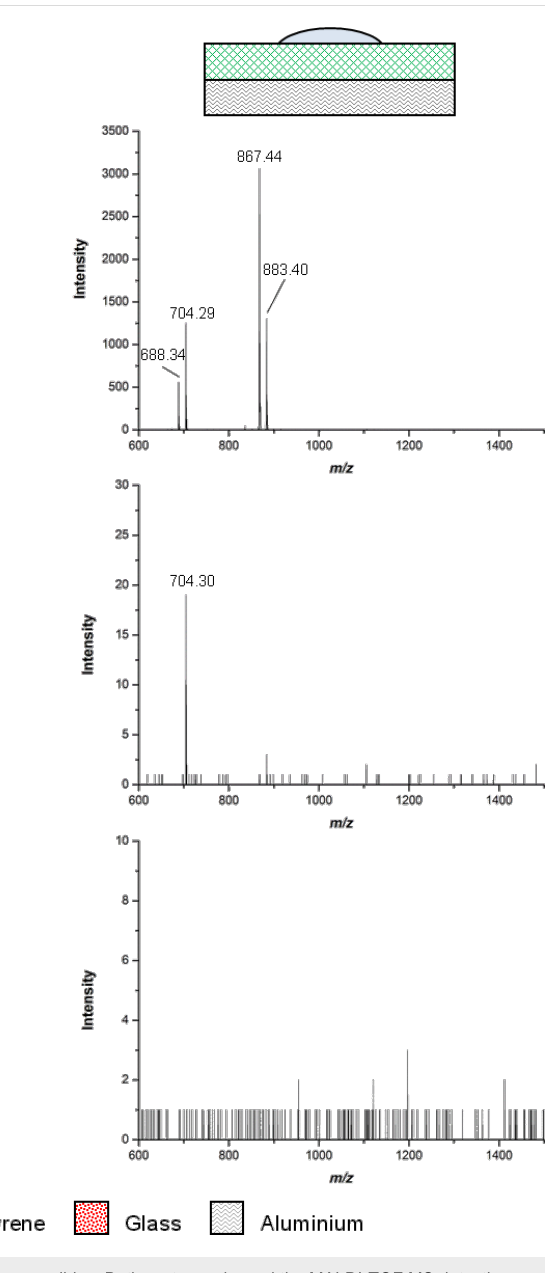
Figure 3: Limit-of-detection analysis of 5 on aluminium-backed glass and polystyrene slides. Both systems showed the MALDI-TOF MS detection limit at 0.5 nmol. The peaks at m / z of 688.3, 704.3, 867.4 and 883.4 correspond to [ 5 + Na] + , [ 5 + K] + , [ 8 + Na] + , and [ 8 + K] + ,